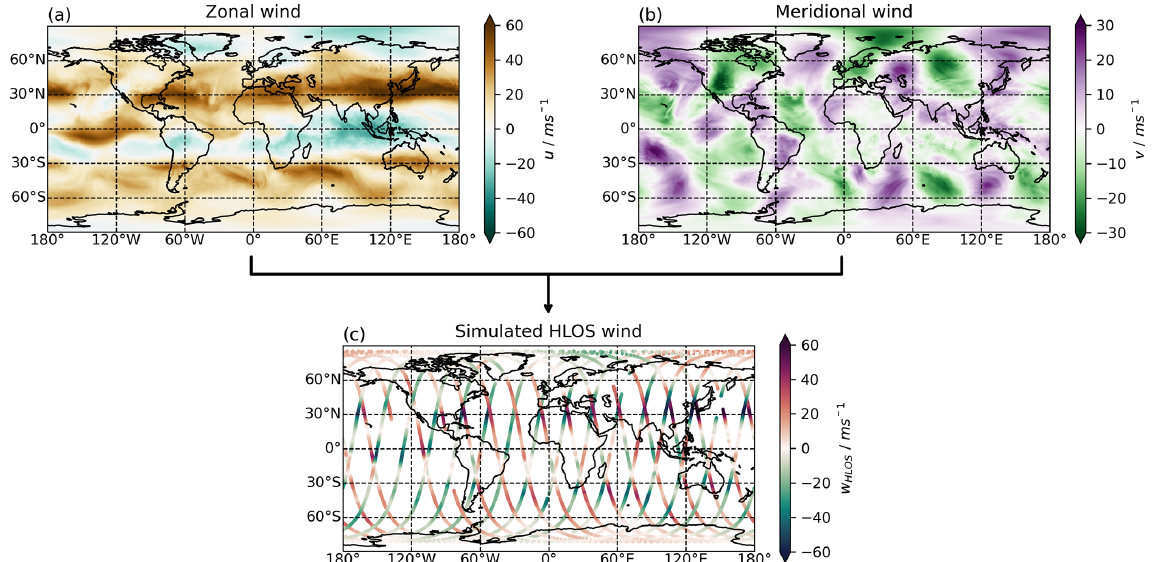
Figure 5. Simulation of Aeolus HLOS wind from ERA5 model data. Panels (a) and (b) show the zonal and meridional wind fields from ERA5 on 15 January 2021, 12:00UTC for an altitude of 15km. Panel (c) shows the simulated Aeolus HLOS wind along track on 15 January 2021. This simulated Aeolus HLOS wind is constructed through trilinear interpolation of hourly ERA5 zonal and meridional wind fields onto the exact times and locations of real Aeolus observations, followed by a conversion into simulated Aeolus HLOS wind following Eq. (3).